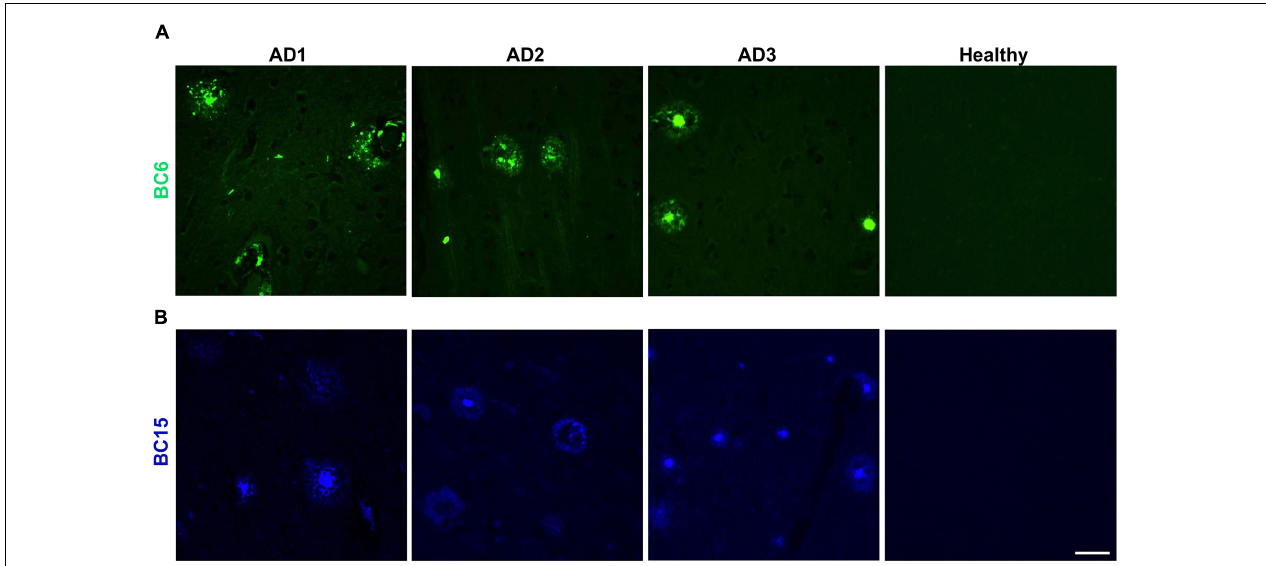
FIGURE 3 | Neuropathological staining of A β plaques with TC derivatives BC6 and BC15. The fluorescent probes BC6 (50 µ M) (A) , and BC15 (1 mM) (B) were used to stain 10 µ m sections from frontal cortex of AD patients, and healthy brain tissue. Many A β plaques were clearly stained with the two dyes in the AD brain sections, while there was no apparent staining in age-matched healthy brain sections. Scale bar 50 µ m.